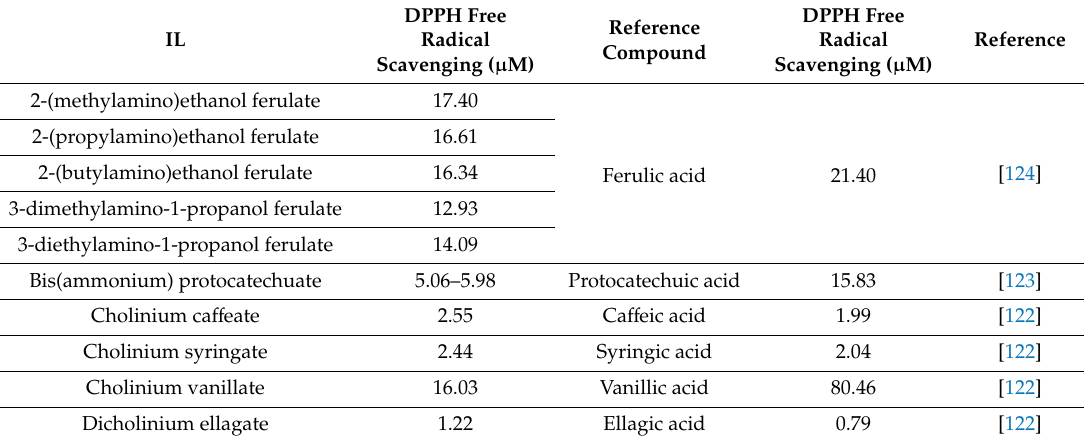
Table 2. Antioxidant activity of ILs and comparison with reference